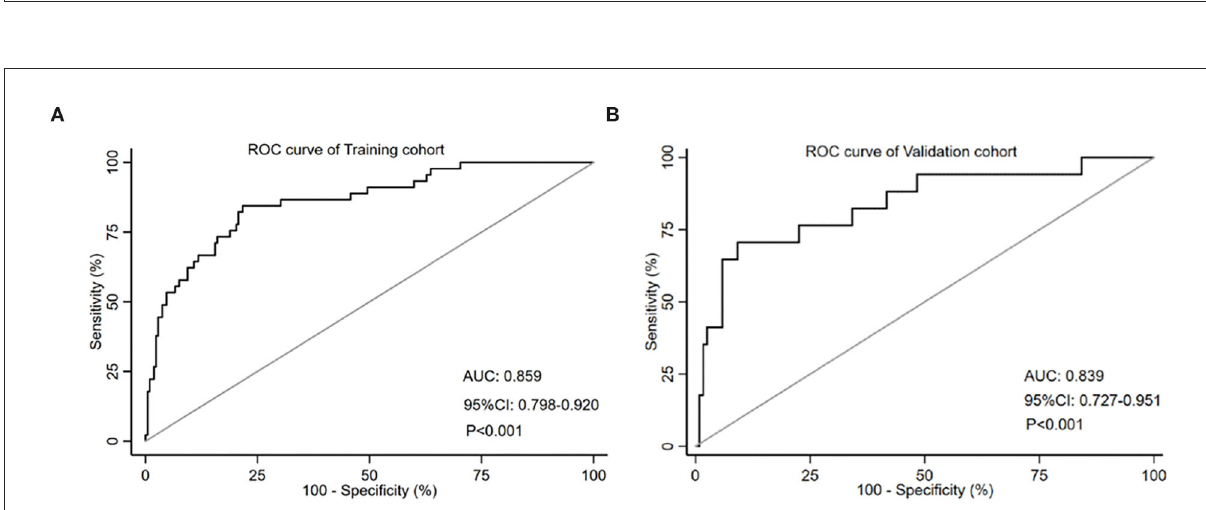
FIGURE3 The ROC curve of the nomogram for predicting HT in the training cohort (A) and the validation cohort (B) . The AUC value is 0.859 in the training cohort and 0.839 in the validation cohort. HT, hemorrhagic transformation; ROC, receiver operating characteristic; AUC, the area under